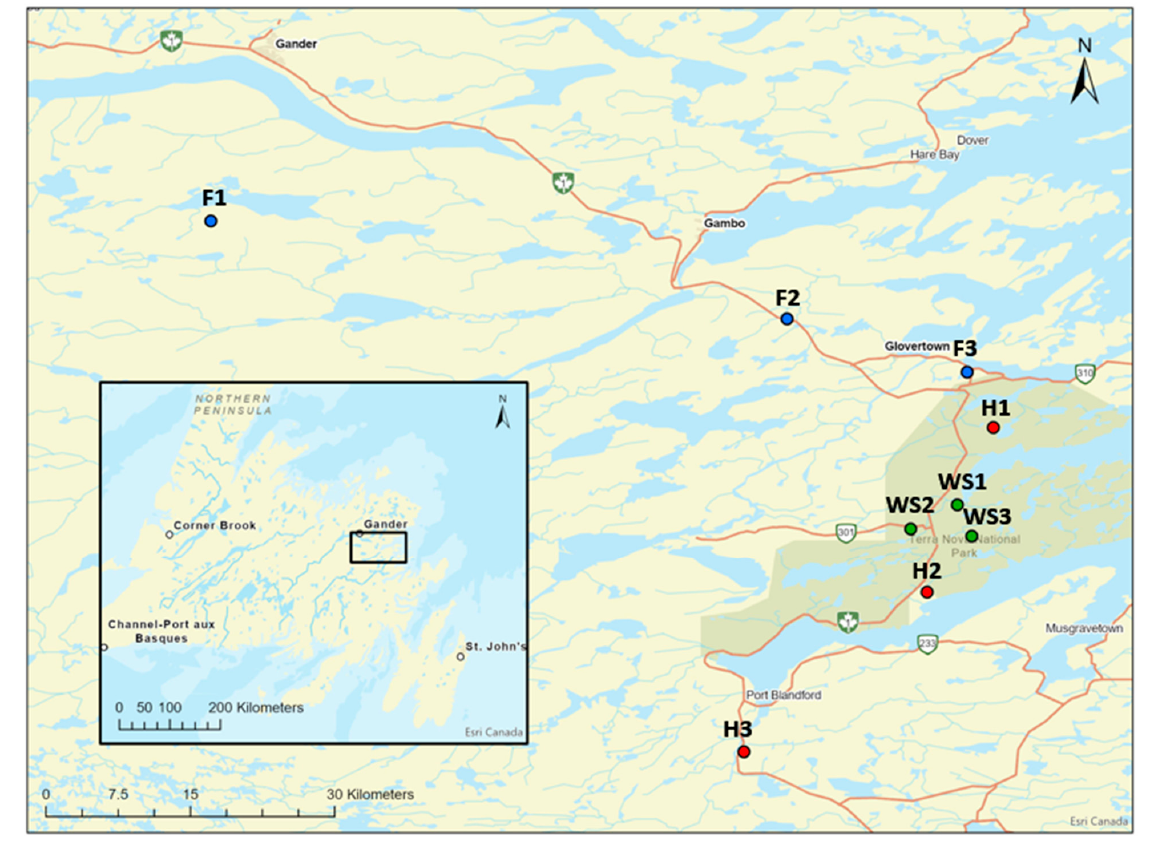
Figure 1. Location of study sites in the forest (F, in blue), heath (H, in red), and wood savannah (WS, in green) communities in Newfoundland, Canada [23]. Table 1 of Siegwart Collier and Mallik 2010 [15] shows the fire history (date of fire, fire weather index, duration of fire, area burned etc.) of the study sites. Table 1. Sampling design and plot replications to determine species abundance in post-fire forest (F), heath (H), and wood savanna (WS) communities.